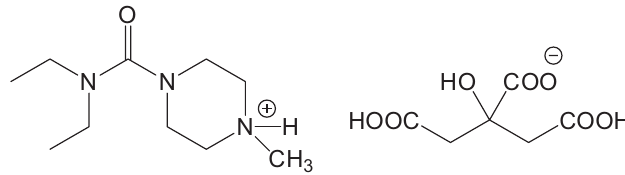
FIGURE 1 - Structure of diethylcarbamazine